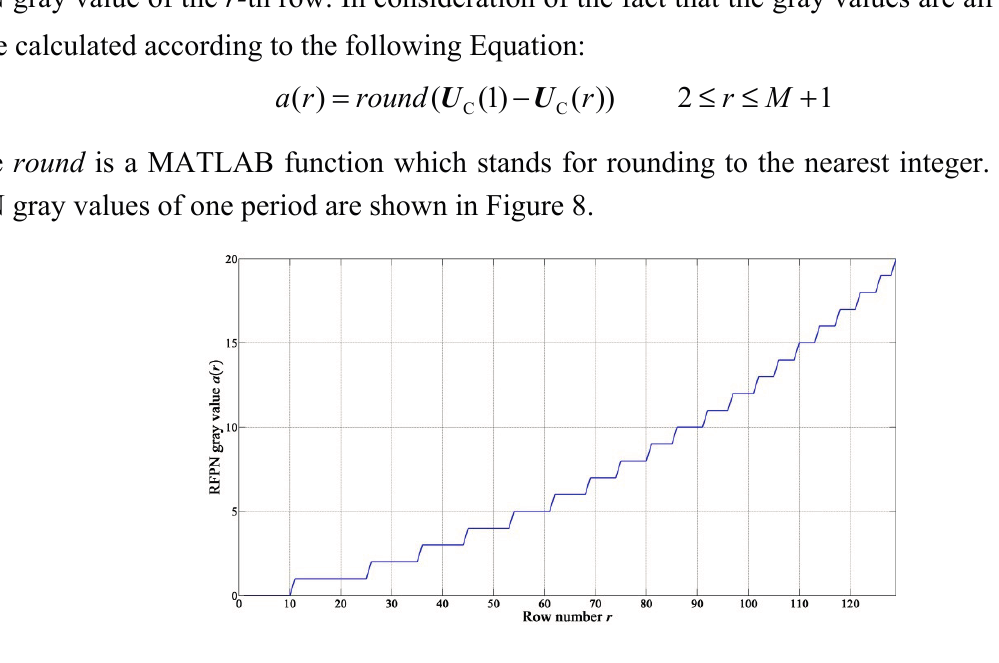
Figure 8. Estimated RFPN gray value ( ) a r versus r of one